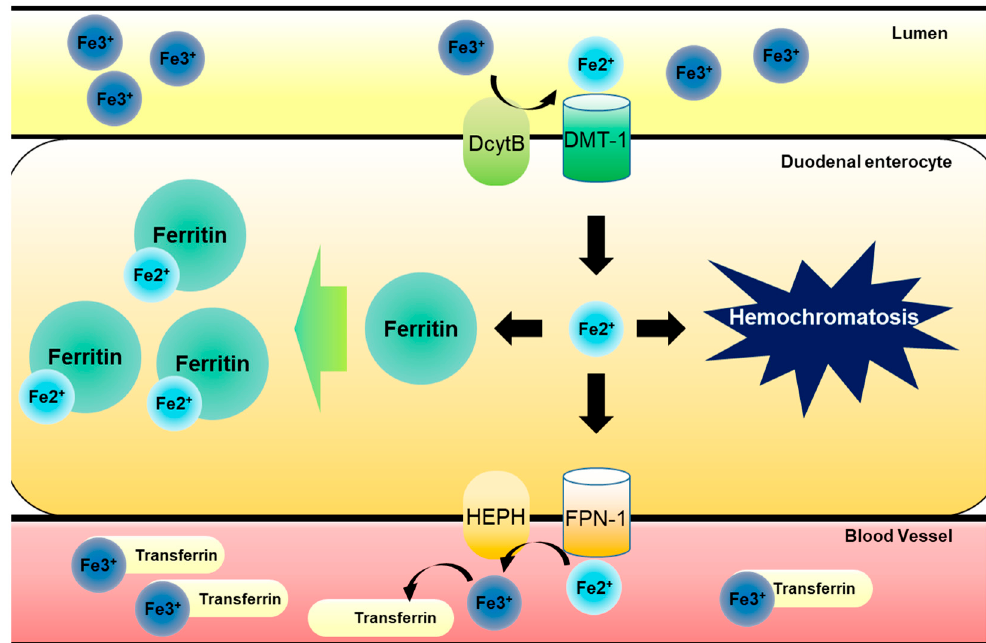
Figure 1. Dietary iron metabolism in gut. Luminal ferric Fe (III) ion from food intake is reduced to ferrous Fe (II) ion by DcytB in apical site of duodenal epithelia. After this, reduced ferrous Fe (II) ion is transported into gastrointestinal enterocytes by DMT-1. Imported ferrous Fe (II) ion have two pathways of modulation. One involves its binding to ferritin, which can store iron ions safely, preventing radial iron ion production, and another pathway involves FPN-1-mediated transport to bloodstream. Exported ferrous Fe (II) ion is then oxidized to ferric Fe (III) ion by HEPH in basolateral site of duodenal epithelial cells. Oxidized ferric Fe (III) ion binds to transferrin circulating bloodstream and is transported to bone marrow for erythrocytosis or liver for storage. However, free ferrous Fe (II) ions can accumulate in cells due to inhibition of the export to bloodstream or increase in import, leading to